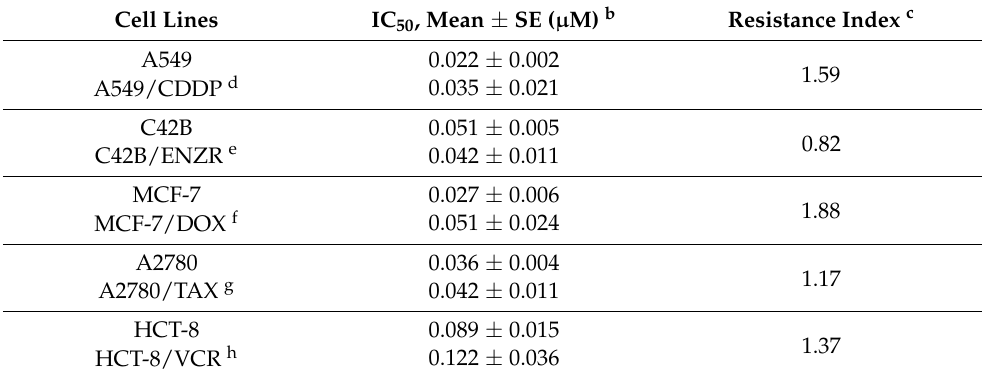
Table 3. Cytotoxicity of compound 14b toward drug-resistant cancer cell lines a